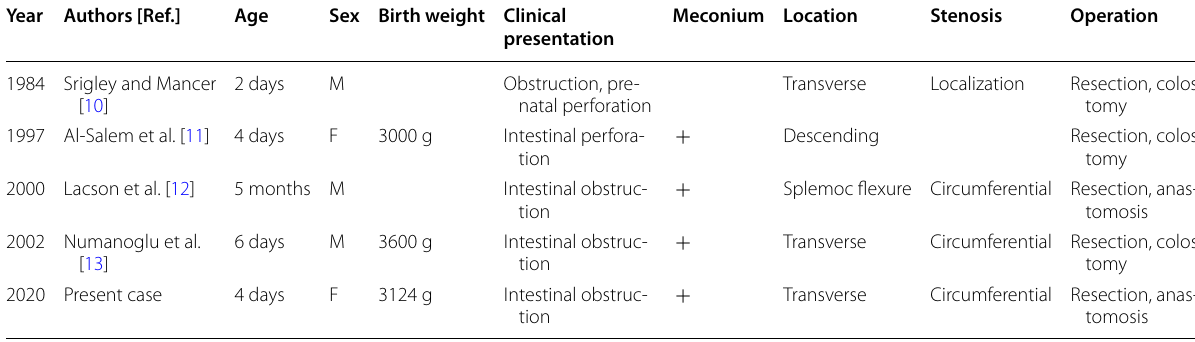
Table 1 Overeview of solitary intestinal myofibromas in the colon Year Authors